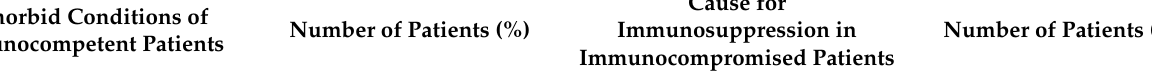
Table 1. Comorbid conditions of immunocompetent patients and cause for immunosuppression in immunocompromised